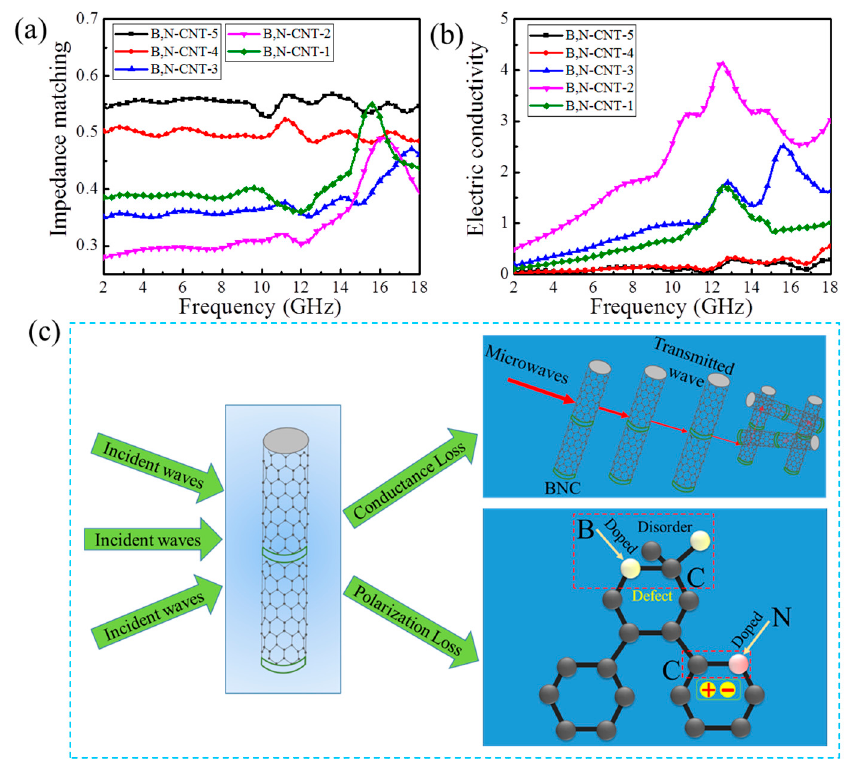
Figure 6. The | Z | curves ( a ), Electric Conductivity curves ( b ), and illustration of the MA performance of B,N-CNTs ( c ).